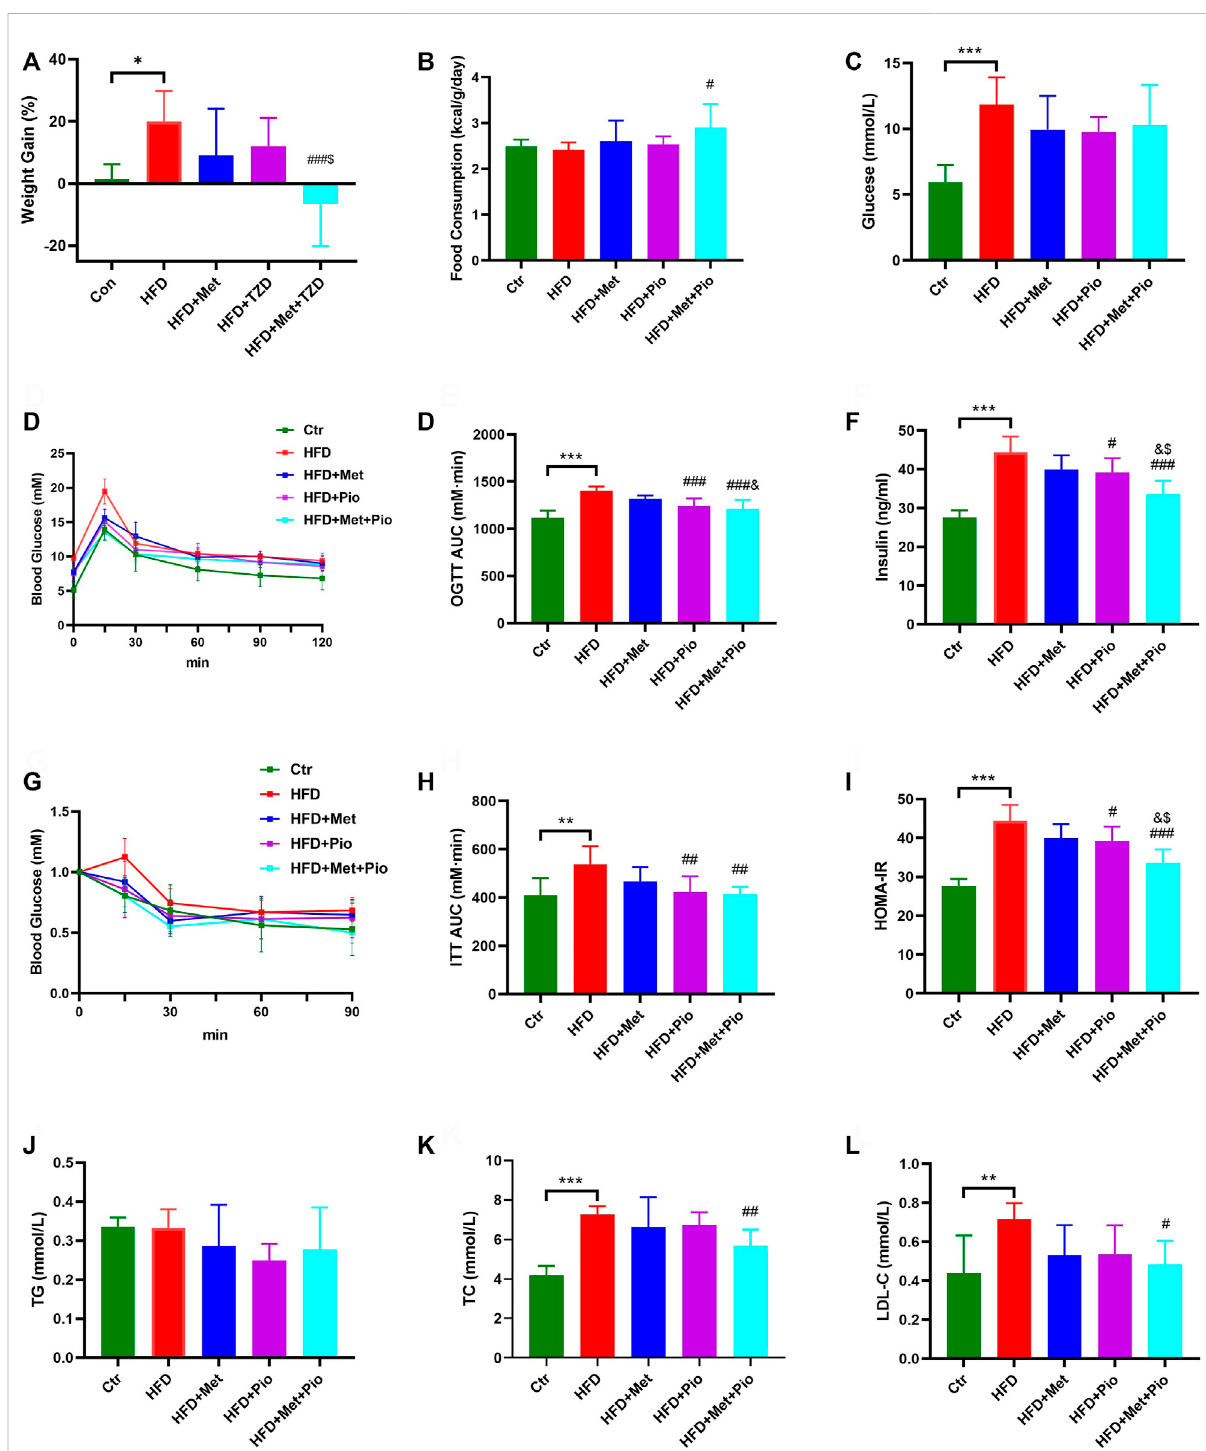
FIGURE 1 Glucose and lipid metabolism improvementwith combination therapy of metformin and pioglitazone. (A) Weight Gain; (B) Food consumption; (C) Fasting serum glucose; (D,E) Oral glucose tolerance test and the area under the curve; (F) Fasting serum insulin; (G,H) Intraperitoneal insulin tolerance test and the area under the curve; (I) HOMA-IR; (J) Fasting serum TG; (K) Fasting serum TC; (L) Fasting serum LDL-C. Ctr, standard control diet;HFD,high-fatdiet;HFD+Met,high-fatdiettreatedwithmetformin;HFD+Pio,high-fatdiettreatedwithpioglitazone;HFD+Met+Pio,high- fat diet treated with metformin and pioglitazone. HOMA-IR, homeostasis model assessment of insulin resistance; TG, triglyceride; TC, total cholesterol; LDL-C, low-density lipoprotein cholesterol. Data are expressed as the means±SDs. ( n = 6 – 7/group). One-way ANOVA; * p < 0.05, ** p < 0.01,*** p < 0.001HFD versus Ctrgroup; # p < 0.05, ## p < 0.01, ### p < 0.001HFD+Metgroup versus HFDgroup,HFD+Piogroup versus HFDgroup,or HFD+Met+Pio group versus HFD group; & p < 0.05, and& p < 0.01, andand& p < 0.001 HFD+Pio group versus HFD+Met group, or HFD+Met+Pio group versus HFD+Met group; $ p < 0.05, $$ p < 0.01, $$$ p < 0.001 HFD+Met+Pio group versus HFD+Pio